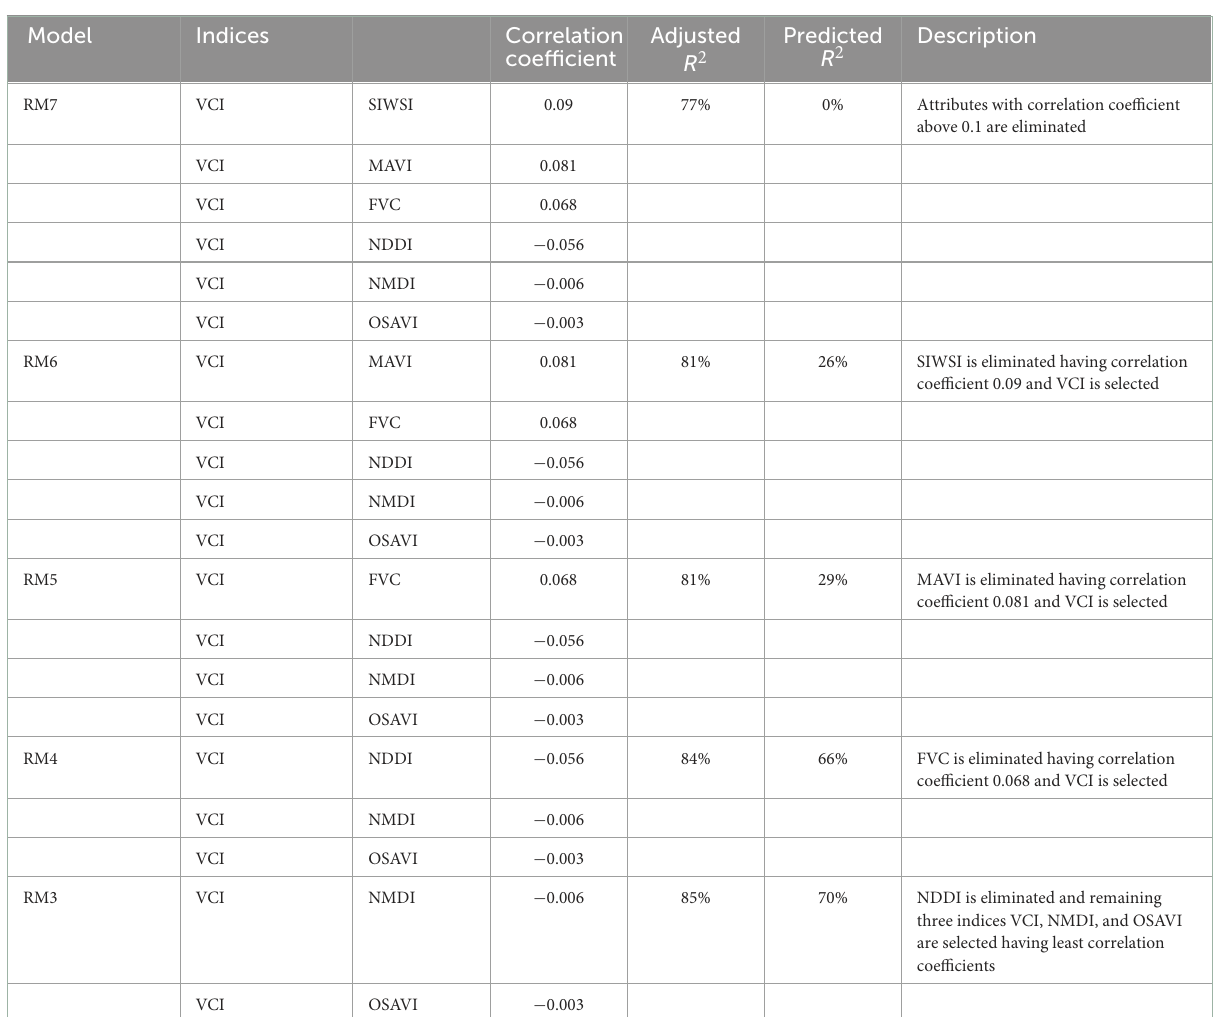
TABLE 2 Accuracy assessment of various reduced models (RMs).